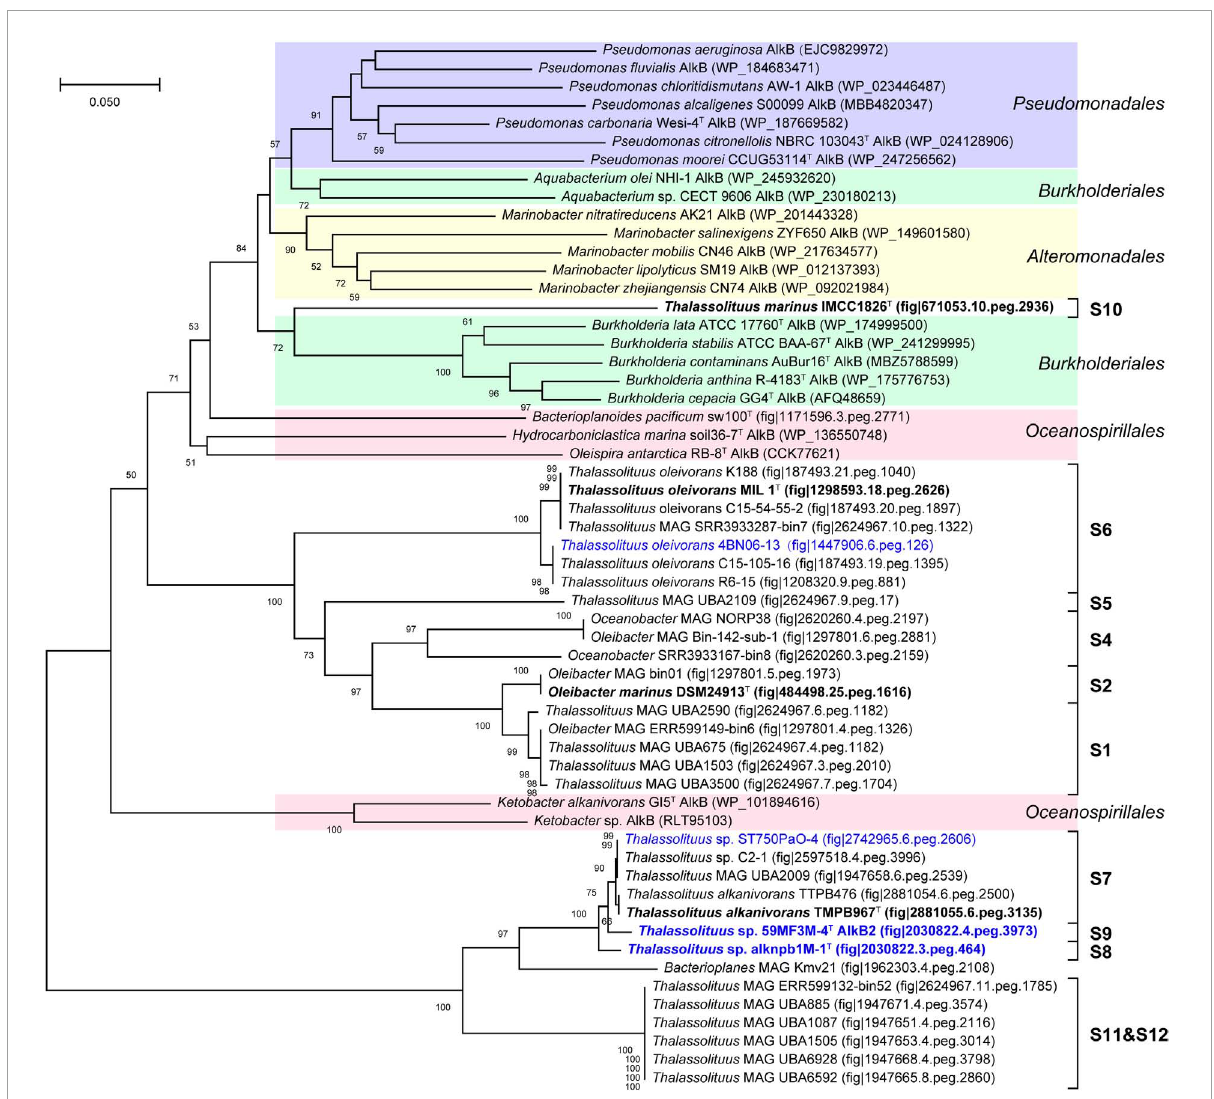
FIGURE7 Neighbor-joining phylogenetic tree of alkane monooxygenase AlkB2 protein sequences derived from hydrocarbon-degrading (HD) group strains of the Oceanobacter -related bacteria (ORB) and their closest reference sequences. Bootstrap values ( > 50%) based on 1,000 resamplings are given at the nodes. The labels in blue and black bold font indicate the sequences obtained from the strains isolated in this study and the type strains of the ORB, respectively. Reference sequences in different shades of color indicate that they originated from different bacterial orders: red, Oceanospirillales ; purple, Pseudomonadales ; yellow, Alteromonadales ; green, Burkholderiales